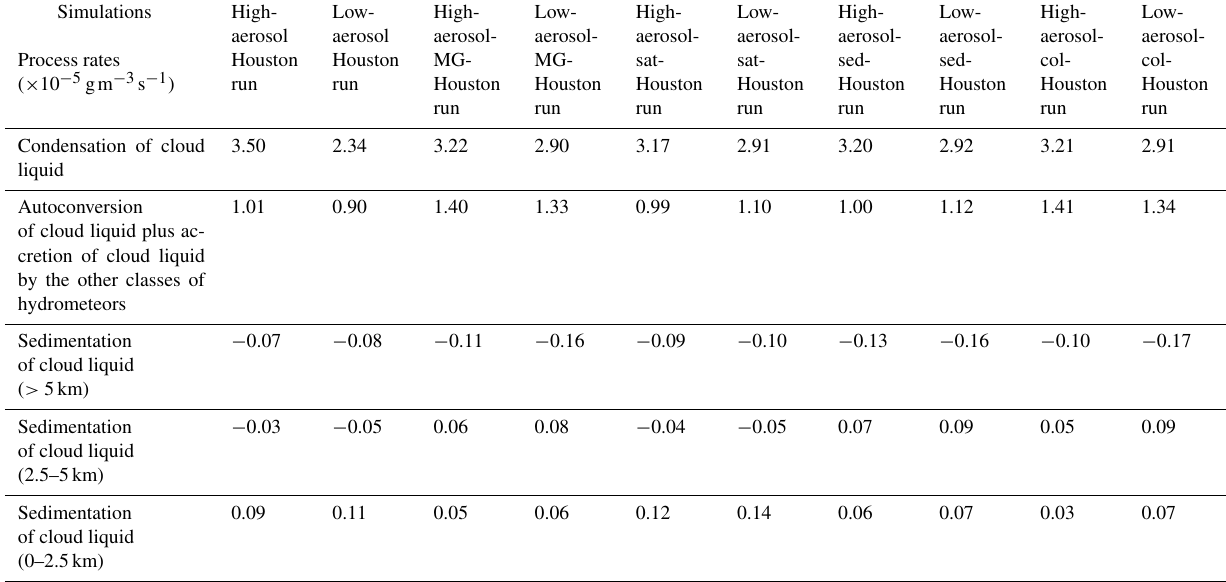
Table 3. Same as Table 2, but for the Houston case.